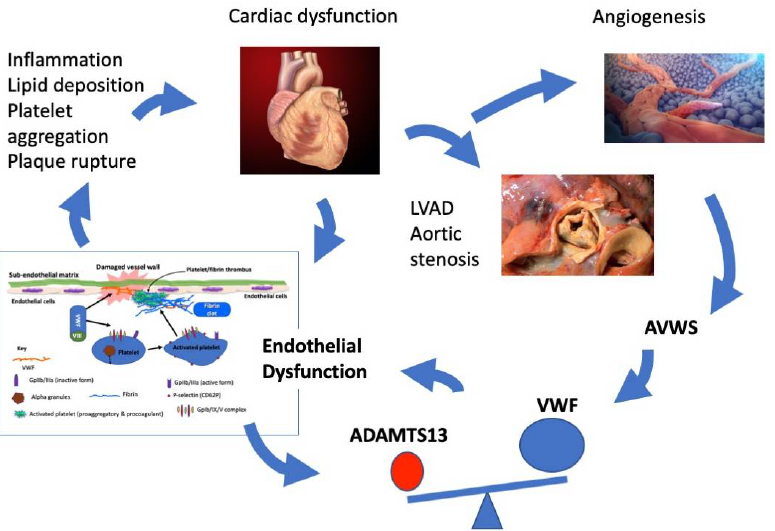
Figure 1. Legend. Original figure from the authors outlining some of the concepts discussed in the review. Abbreviations: ADAMTS13, a disintegrin and metalloproteinase with thrombospondin type